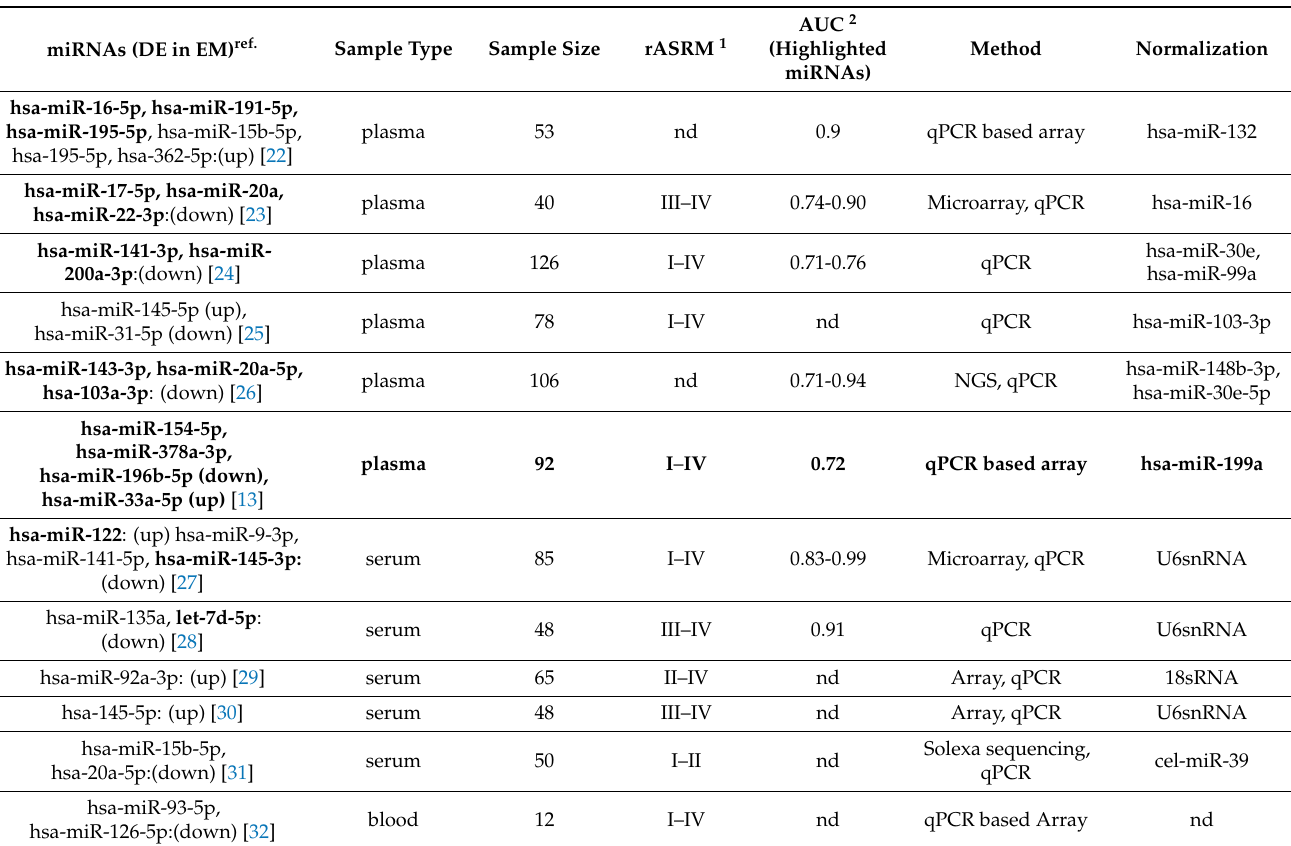
Table 1. Overview of previously reported putative noninvasive miRNAs biomarkers for endometrio- sis that were included in the focused miRNA panel in this study.